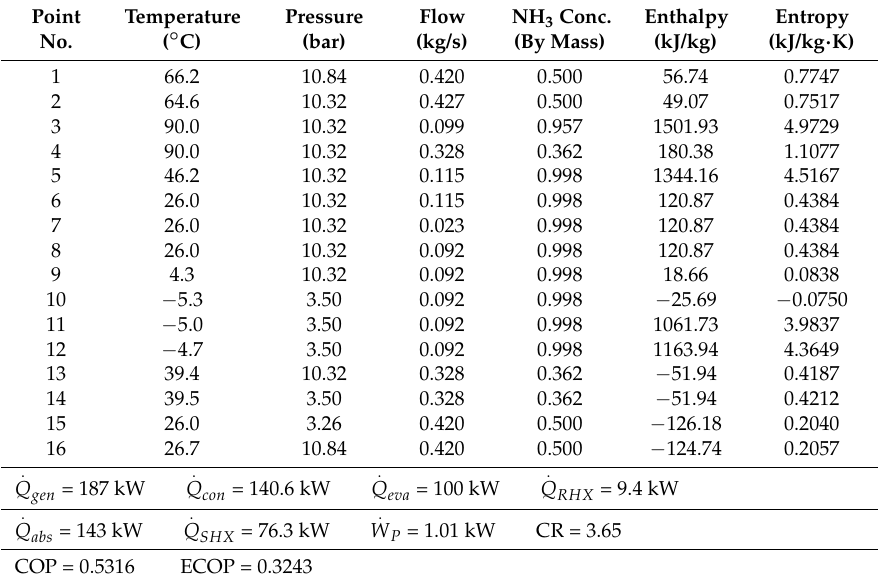
Table 2. Results of system analysis at base condition.